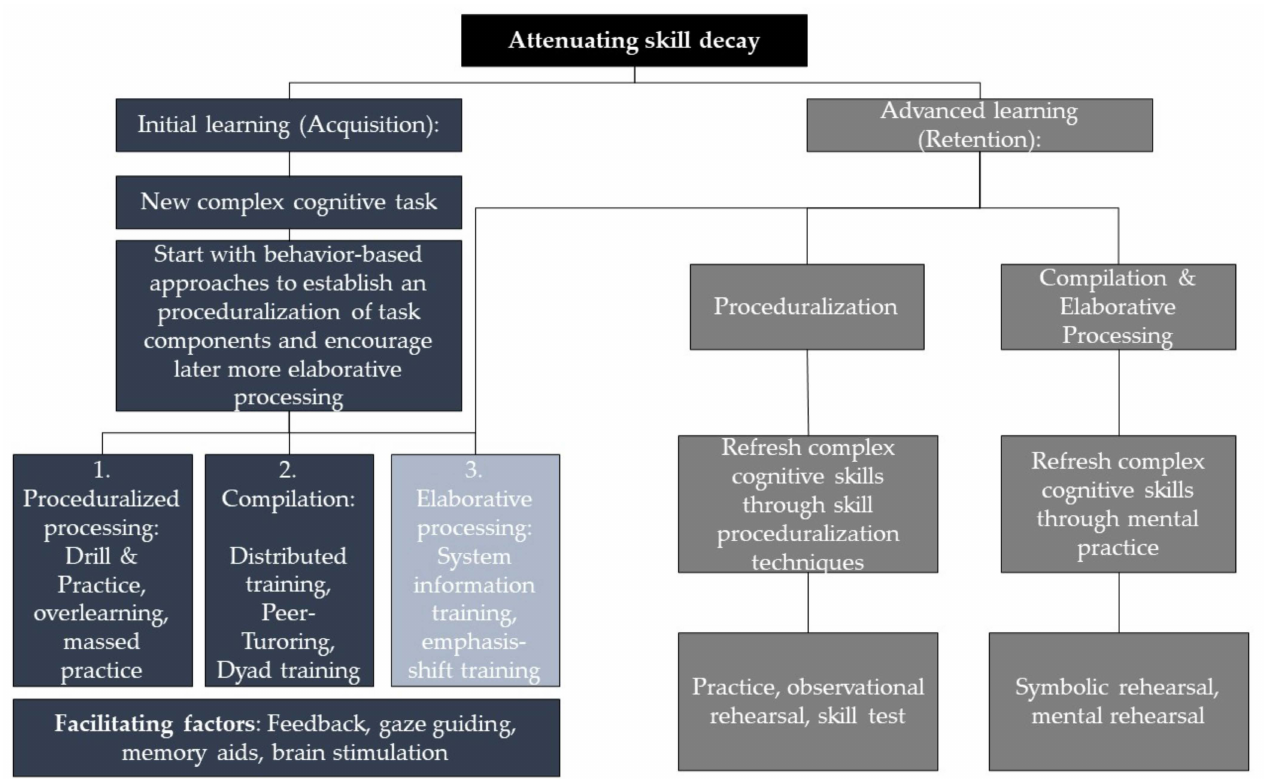
Figure 3. Recommendations for attenuating skill